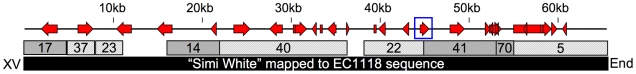
65kb insertion in subtelomeric region of chromosome XV.This map shows the positions of open reading frames within a novel chromosome XV subtelomeric region common amongst some wine strains. The blue box denotes the position of the putative xylitol dehydrogenase homolog. Numbered boxes represent Velvet contigs created from de novo assembly of the filtered (solid = Watson strand, hashed = Crick strand), unmapped reads compiled from the three positive pools. The black box represents the 65kb region identified by the EC1118 wine yeast genome sequence used to map the Simi White unmapped reads and find all the open reading frames in the region.